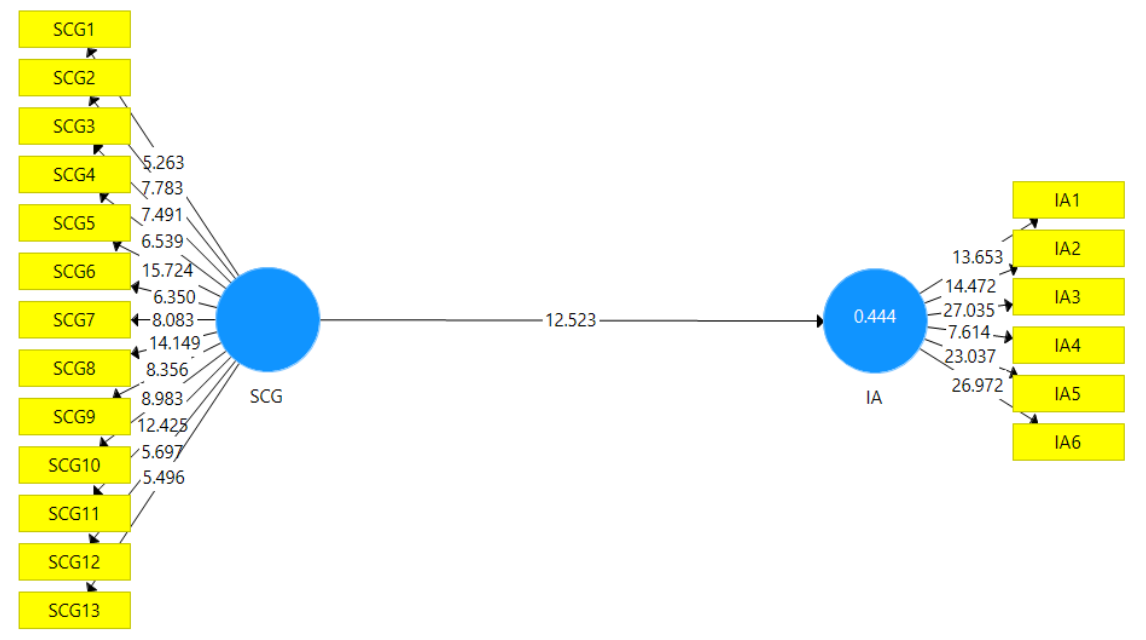
Figure 2. Direct Effect—Path Coefficient and t -values.